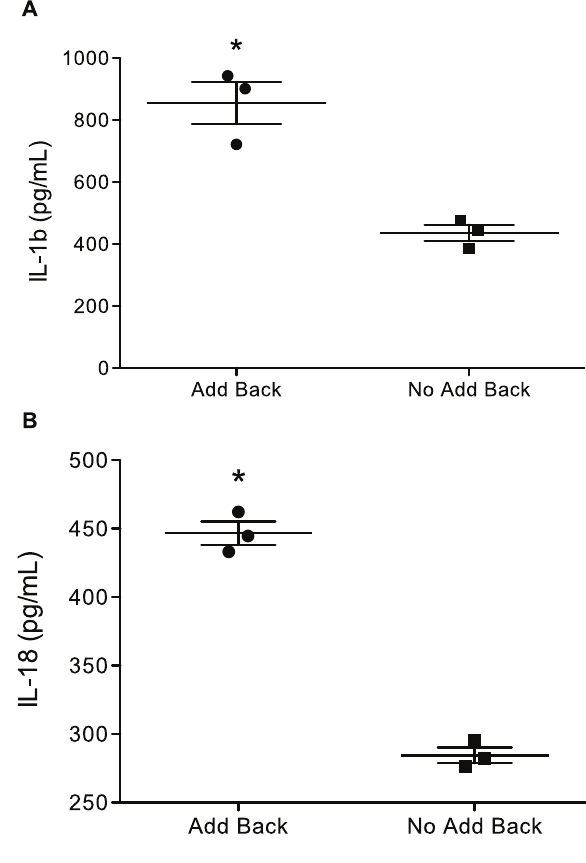
Figure 3. Cytokine profile of M.tb- infected macrophages in the presence or absence of naı¨ve macrophages. Macrophages were infected with M.tb Erdman (MOI 50) for 3 h then cultures were washed and the infected cells were resuspended in medium alone or medium plus an equal number of naı¨ve macrophages. After an additional 3 h in culture, supernatants were collected, and frozen at 2 80 u C until multiplex cytokine analysis. Concentrations of IL-1 b and IL-18 are shown for co-cultures of infected and uninfected macrophages ( add back ) or culture of M.tb -infected macrophages without naı¨ve macro- phages ( no add back ).